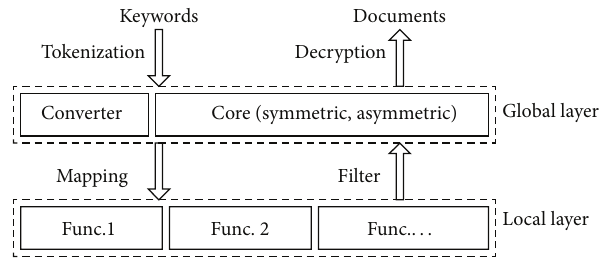
Figure 1: Architecture for layered searchable encryption